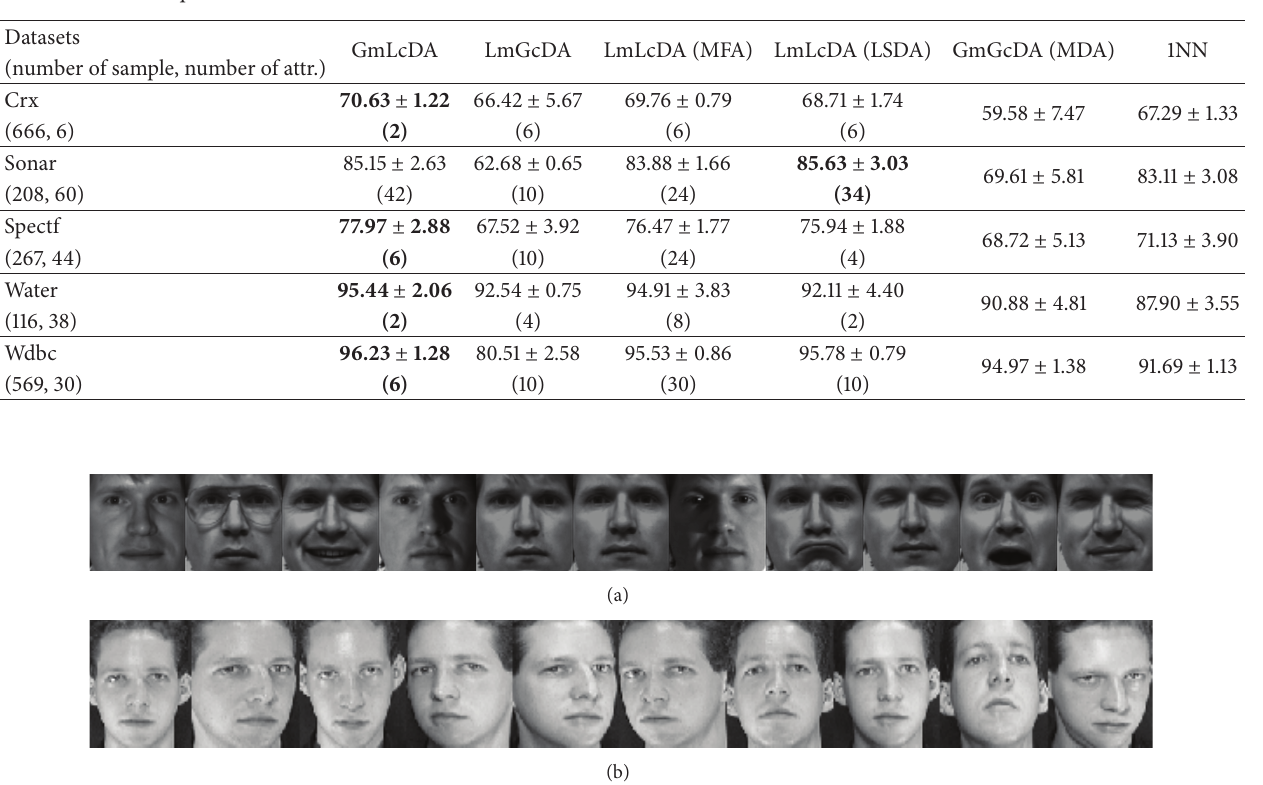
Table 1: Accuracy% ± standard deviation (optimal reduced dimensions), where the reduced highest dimension of MDA is number of class subtract one, here equals one.